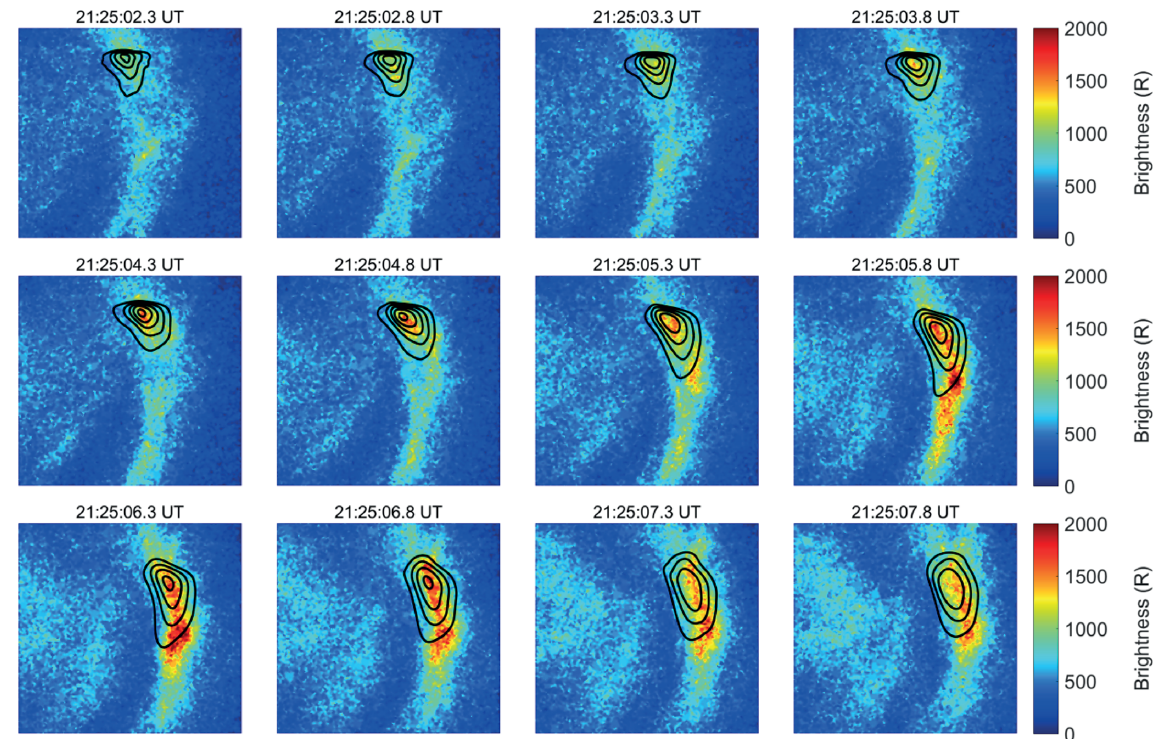
Figure 7. A sequence of observed images of the 732.0nm emission. The black lines are model brightness contours from 400 to 800R at 100R intervals.